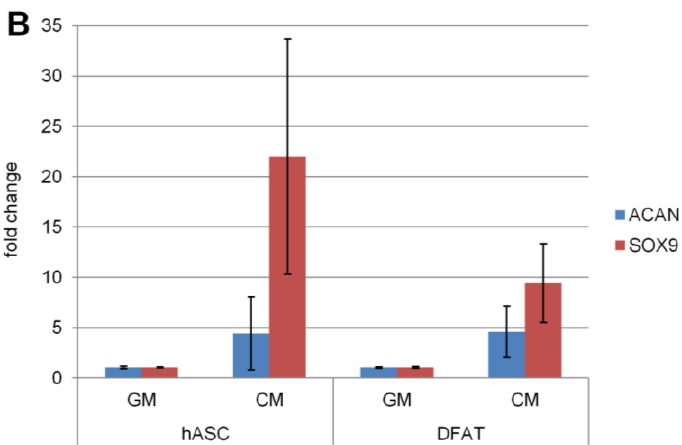
Figure 4. Chondrogenic differentiation in hASC and DFAT in the presence (CM: chondrogenic medium) or absence (GM: growth medium) of chondrogenic factors. ( A ) Microscopic evaluation of acid mucopolysaccharides in hASC ( a ) and DFAT ( b ) cells and their respective control (inset) by Alcian Blue 8GX stain at 30 days. Bars, 100 µm; ( B ) expression of ACAN and SOX9 of DFAT and hASC cells after 30 days in culture. Data are expressed as fold change of cells in a chondrogenic medium versus a growth medium.